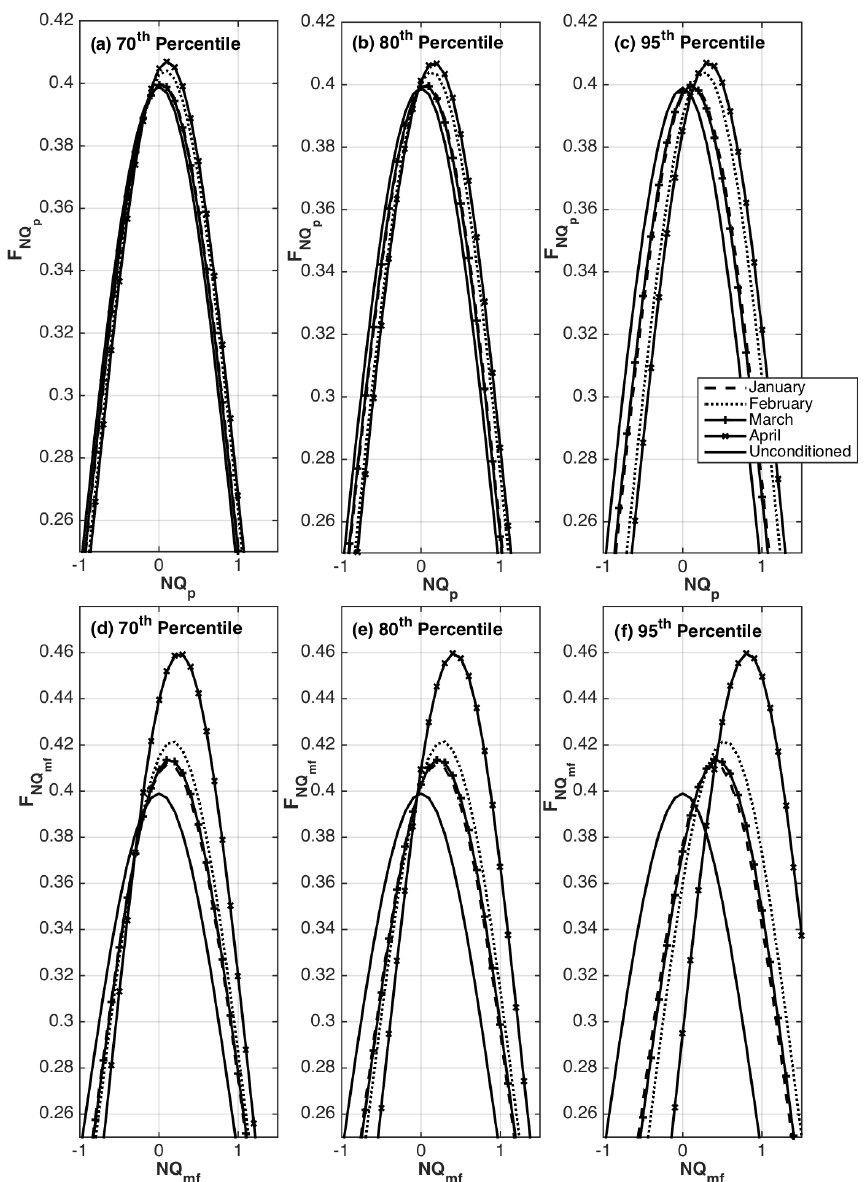
Figure 6. Probability distribution functions of the normalized dependent variables (NQ p and NQ mf ) conditioned to the occurrence of the 70th, 80th and 95th percentiles of the normalized variables in the pre-flood season in the upper Danube.